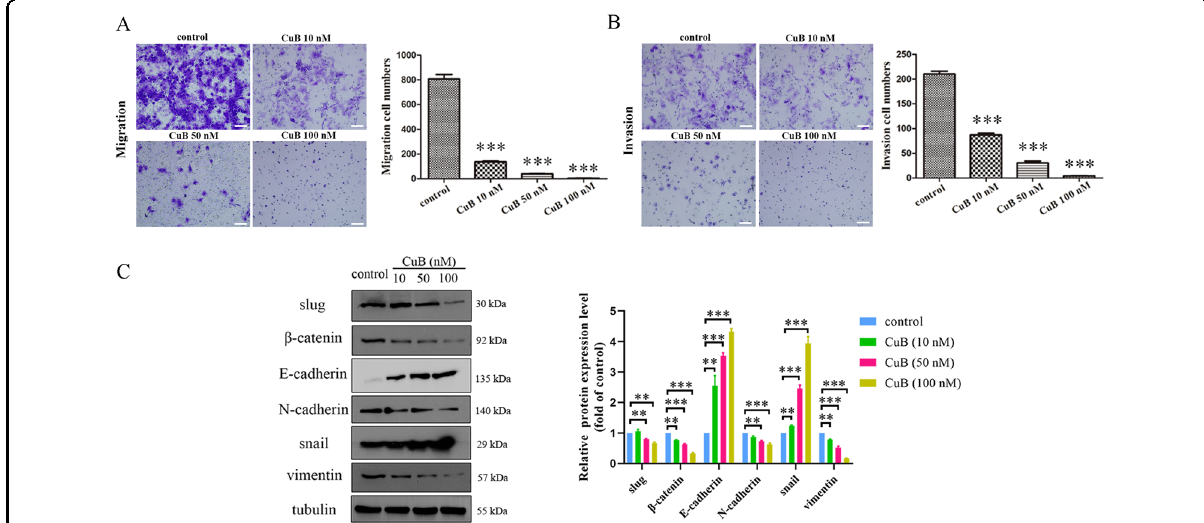
Fig. 6 The effects of CuB on migration and invasion in CNE1 cells. A , B After 24 h of incubation with CuB (10, 50, and 100 nM), migratory and invasive behaviours were analysed using migration and matrigel invasion assays in CNE1 cells. *** p < 0.001 vs . control group by t -test using GraphPad Prism 5.0. Scale bars: 100 μ m. C Western blot analysis of expressions of slug, β -catenin, E-cadherin, N-cadherin, snail, and vimentin in CNE1 cells with CuB (10, 50, and 100 nM) treatment for 48 h. Quantitative analysis of western blots was performed by Image J (NIH, MD, USA). ** p < 0.01 and *** p < 0.001 vs . the control group by t -test using GraphPad Prism 5.0. Data were presented as the mean ± SEM of three independent